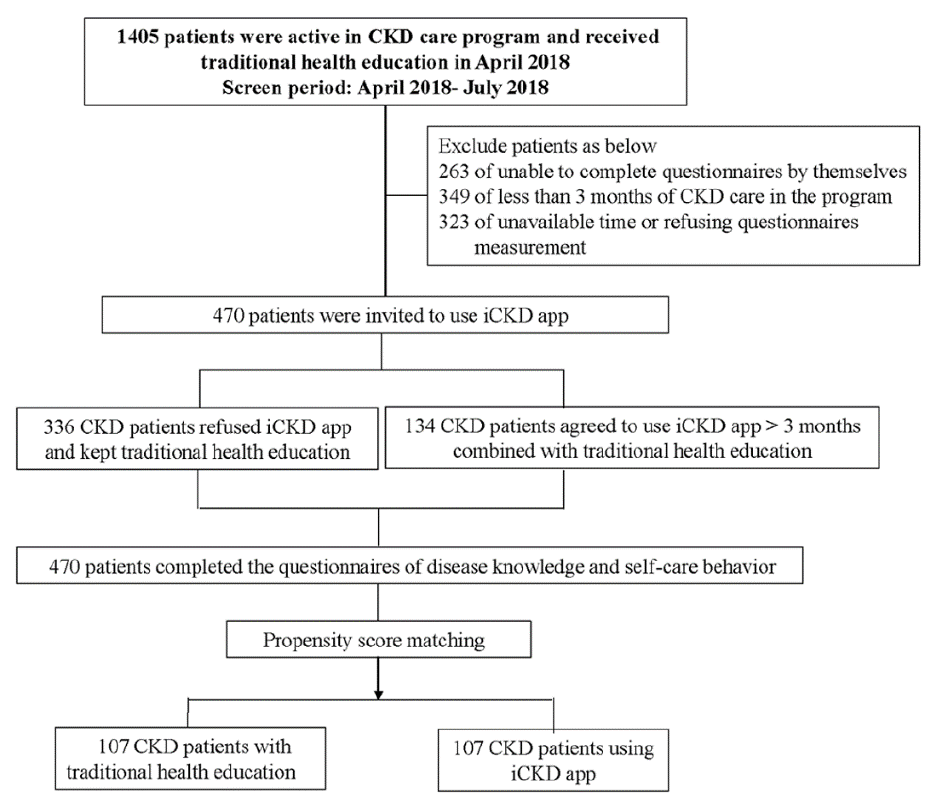
Figure 1. The flow chart of this study.